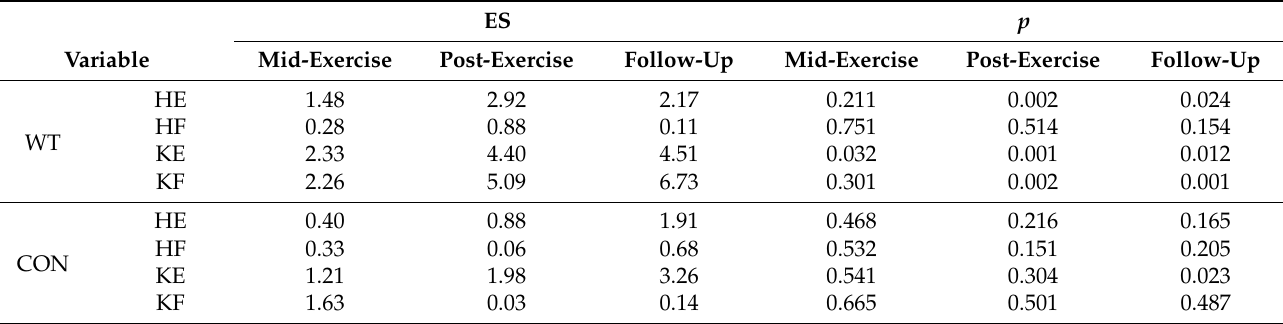
Table 3. The effect sizes and p -values of comparison of muscle strength between different time points and baselines within the WT and CON groups.